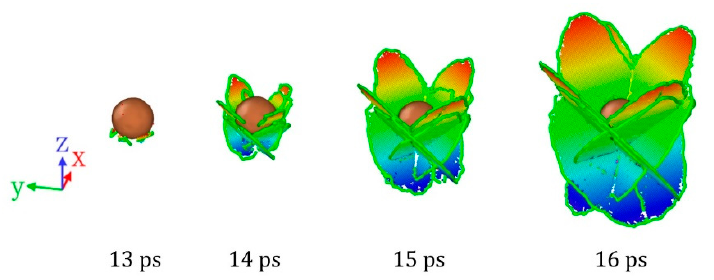
Figure 5. Dislocation and stacking fault structure near Cu inclusions at different times when u p = 0.8 km/s. The atoms are rendered by Z positions to enhance the stereoscopic